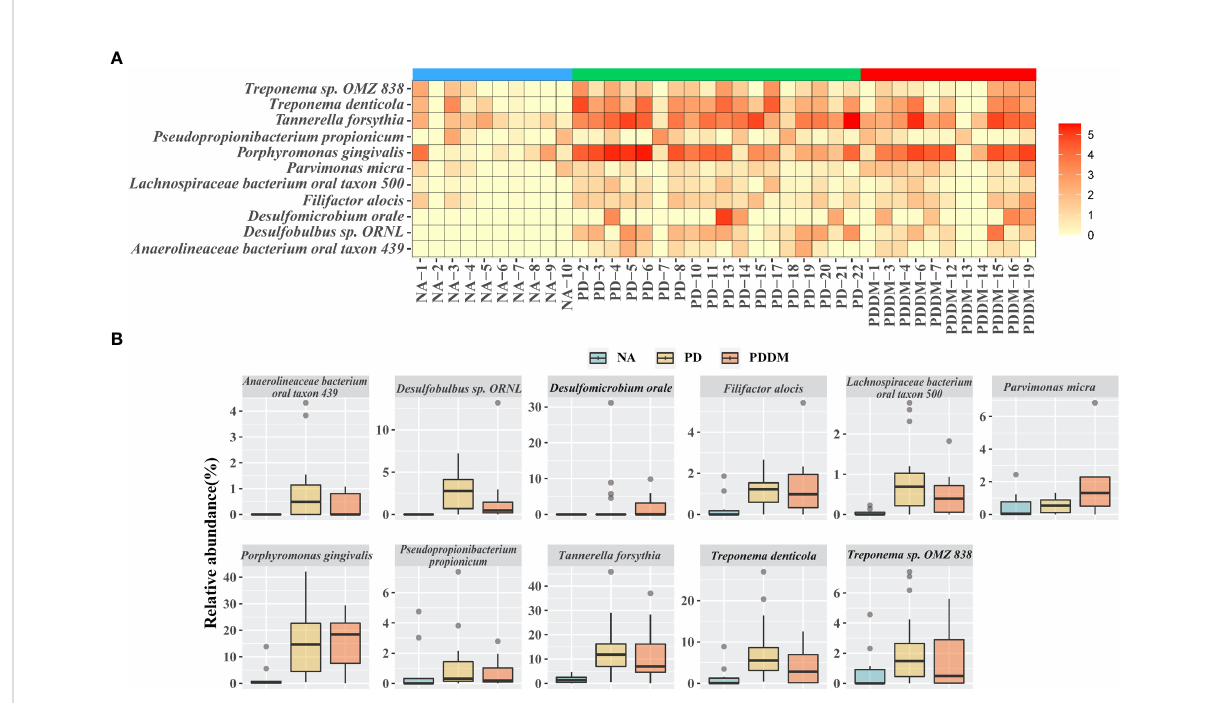
FIGURE 2 Key microbiome changes between NA and PD or PD_DM by differential abundance analysis. (A) Heatmap of the relative abundances (log2 transformed) and most abundantly present species in the PD or PD_DM. (B) Abundances of 11 signi fi cantly different bacterial species. Boxplots represent relative abundance of individual species in each group. A p-value < 0.05 is considered signi fi cant and the cutoff average relative abundance is >